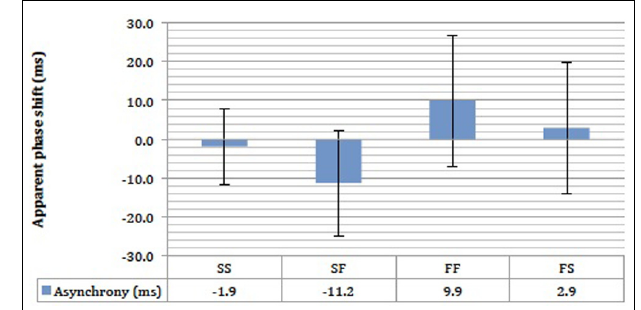
FIGURE 9 |The results of the motion-motion pairing experiment for four subjects. UDLR = up–down against left–right ; UDUR = up–down against up-right ; S = slow speed setting; F = fast speed setting. Error bars represent standard error of means (SEMs).